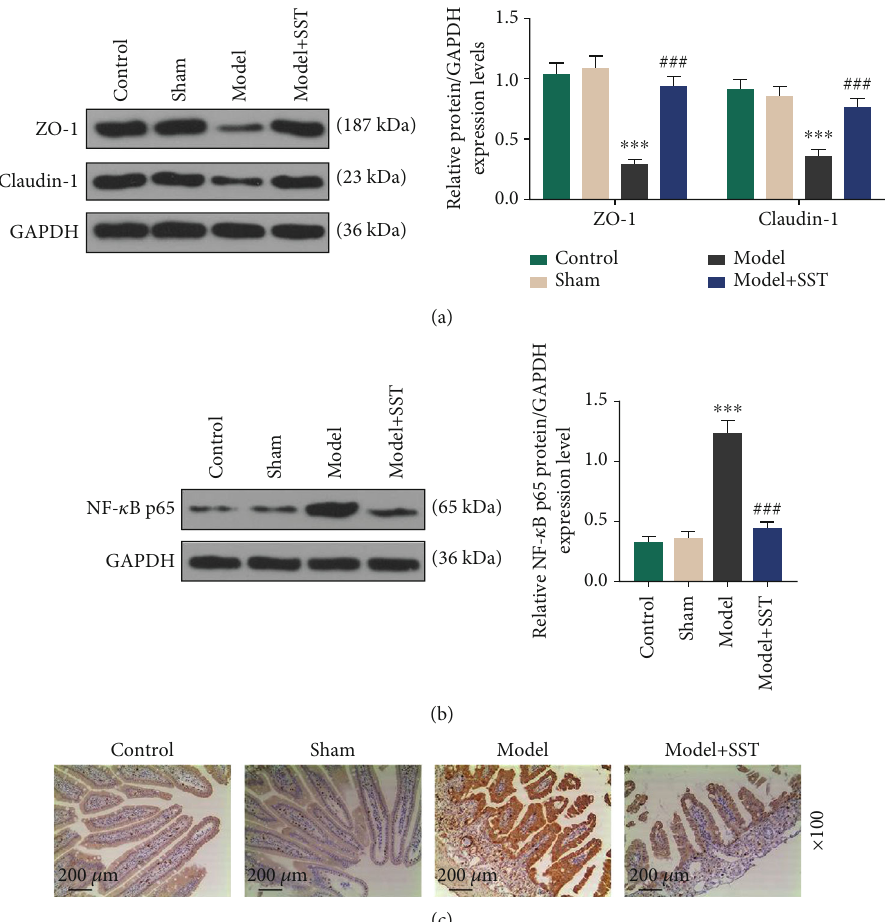
Figure 2: SST prevented the reduction of tight junction protein expressions and the activation of NF- κ B p65: (a) western blot analysis of tight junction proteins, ZO-1 and Claudin-1, in the ileum; (b, c) western blot and immunohistochemistry analysis of NF- κ B p65 in the ileum. Magni fi cation: 100x. Scale bar: 200 μ m. Data were shown as the mean ± SD from 3 independent experiments. ∗∗∗ P < 0 : 001 , vs. sham; ### P < 0 : 001 , vs. model. ZO-1: zonula occludens 1; SST: